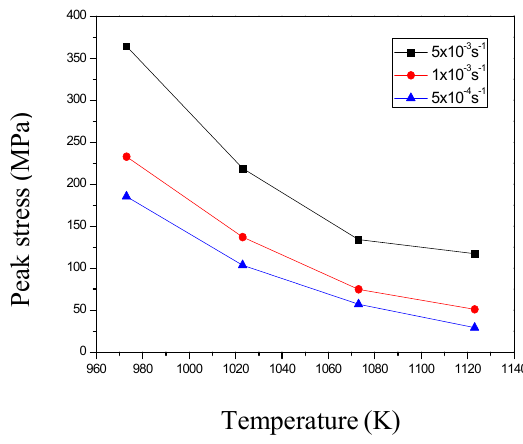
Figure 4. Peak stress as a function of temperature at different initial strain rates.